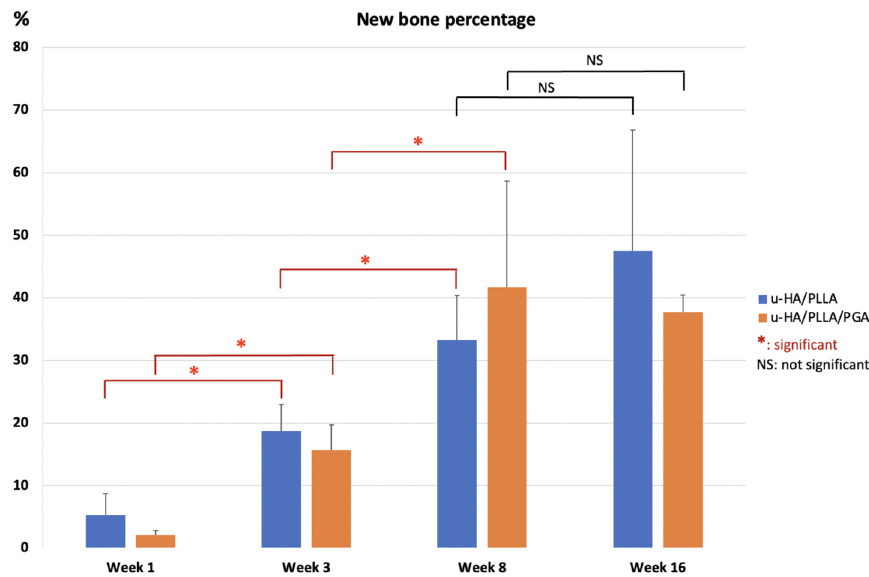
Figure 10. Percentages of new bone area in histomorphometric evaluation of u-HA/PLLA and u-HA/PLLA/PGA groups. * p < 0.05.